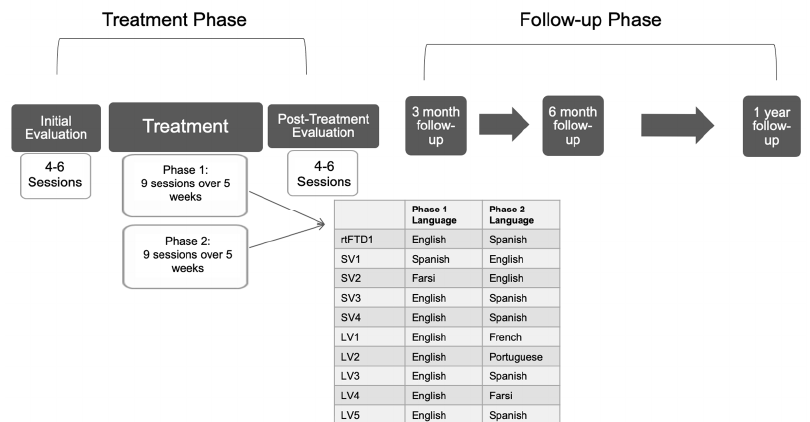
Figure 2. Schematic depicting chronology and duration of participation. rtFTD = right temporal variant of frontotemporal dementia; SV = semantic variant; LV = logopenic variant. Table 3. Lexical Retrieval Cascade Used During Treatment Sessions (Henry et al., 2013;